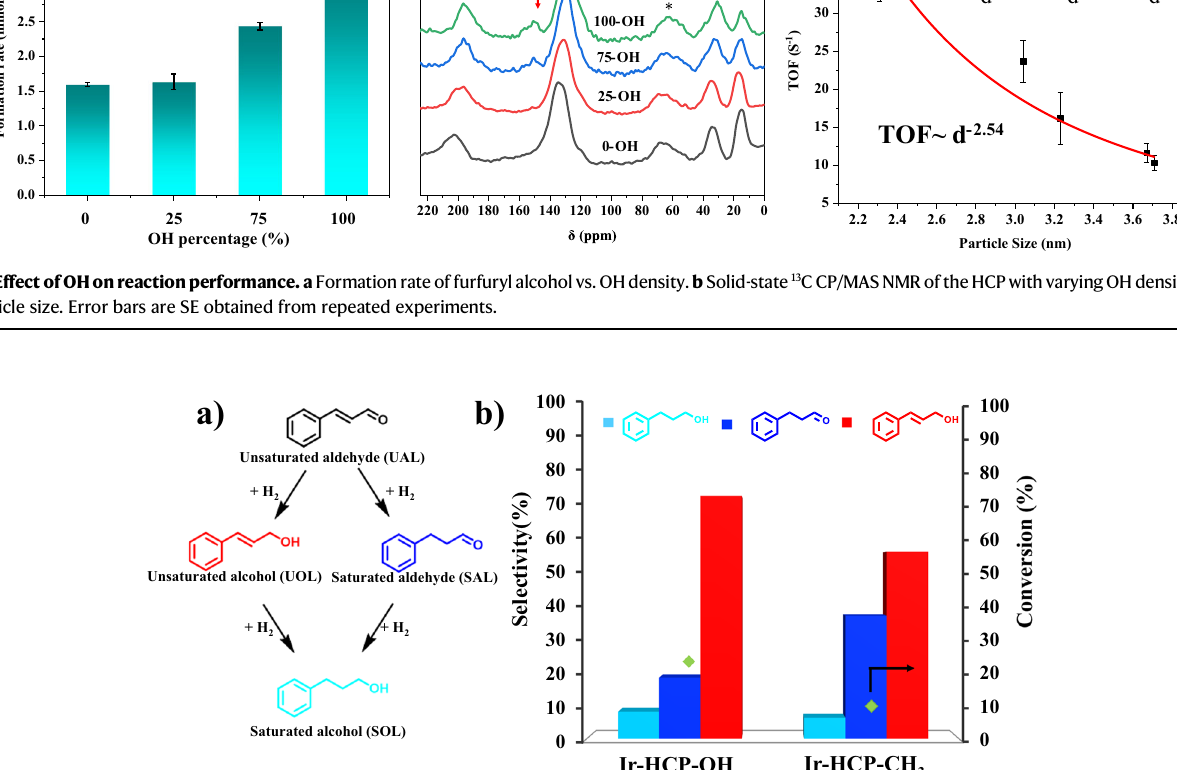
Fig. 6 | Hydrogen bond effect on selectivity. a Reaction routes of cinnamaldehyde hydrogenation. b Selectivity difference over Ir-HCP-OH and Ir-HCP-CH 3 in the cinnamaldehyde